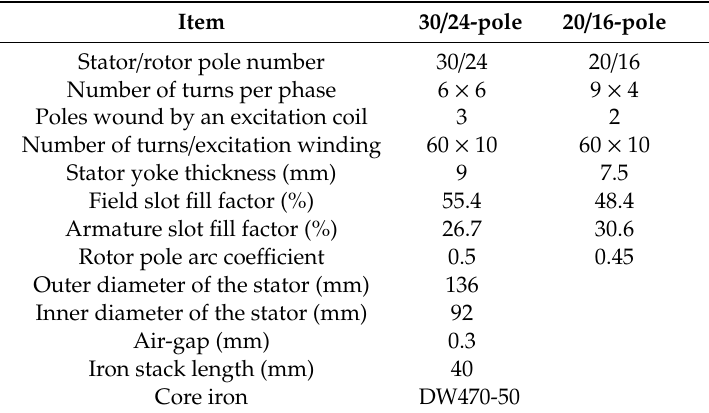
Table 1. Parameters of five-phase